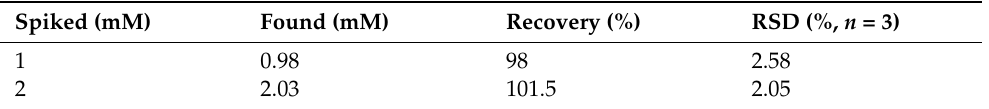
Table 2. Determination of H 2 O 2 in urine